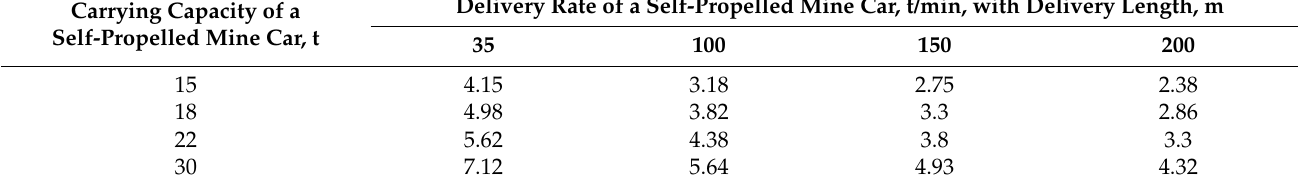
Table 3. Ore delivery rates using self-propelled mine cars. Carrying Capacity of a Self-Propelled Mine Car,